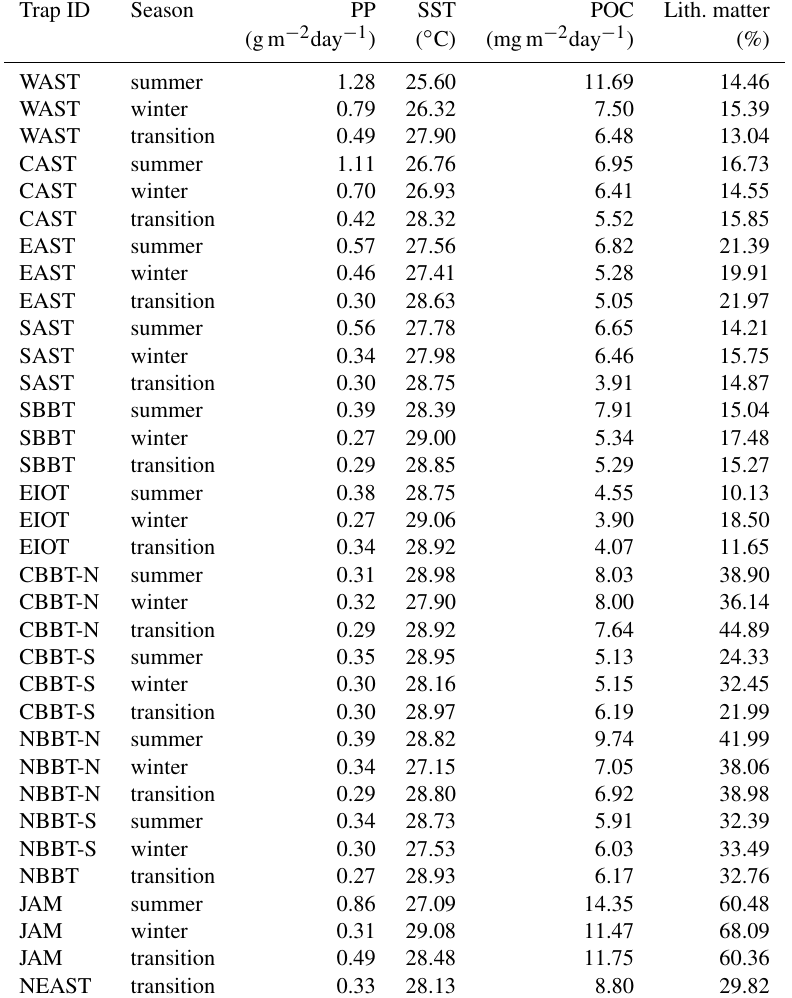
Table 2. Trap ID, season, seasonal averaged primary production, sea surface temperature, organic carbon flux and lithogenic matter content. Trap ID